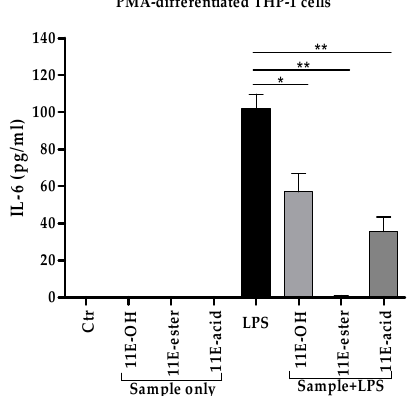
Figure 5. E ff ect of eicosenoid compounds on the production of IL-6 by phorbol 12-myristate 13-acetate (PMA)-di ff erentiated THP-1 cells in the absence and presence of LPS (0.5 µ g / mL). The IL-6 levels were significantly decreased in all three combination treatments when compared with positive control LPS ( n = 3). Ctr: Untreated control; LPS: Lipopolysaccharide; (11E-OH): (Z)-11-eicosenol; (11E-ester): Eicosenoate; (11E-acid): Eicosenoic acid; *: Significant ( p < 0.05); **: Significant ( p <